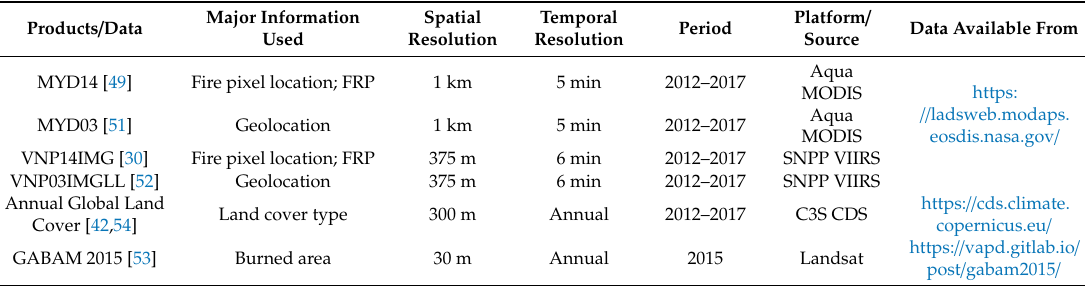
Table 1. Specifications of products and data applied in this